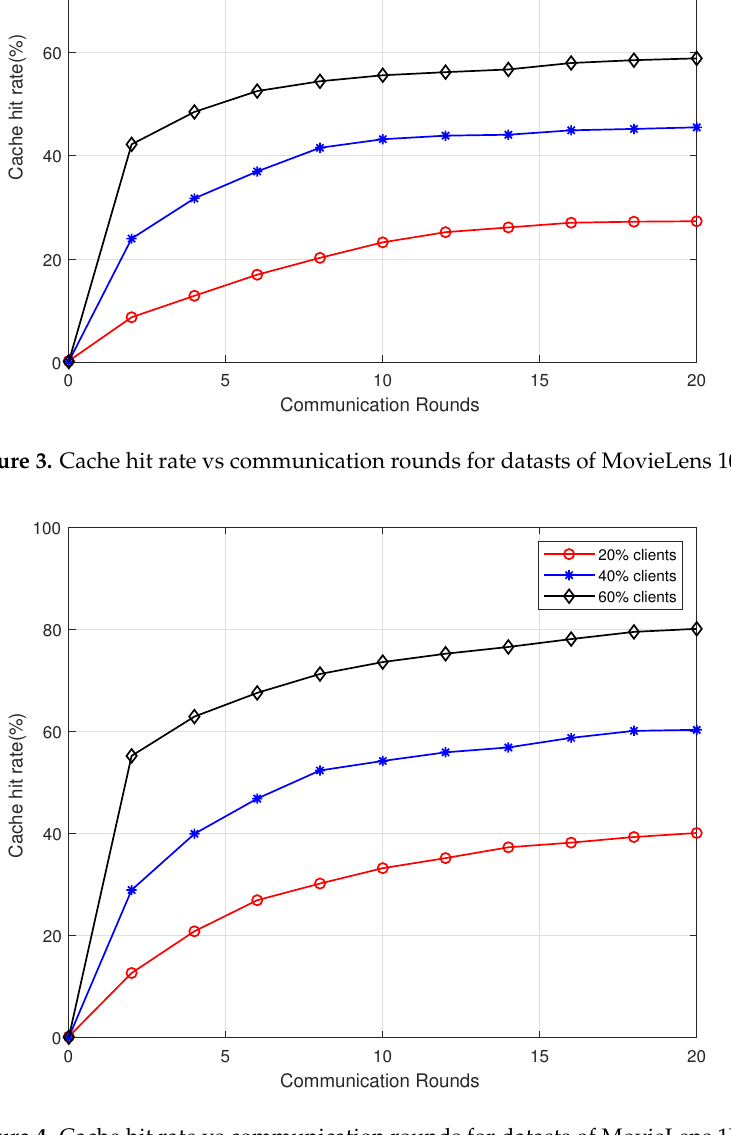
Figure 4. Cache hit rate vs communication rounds for datasts of MovieLens